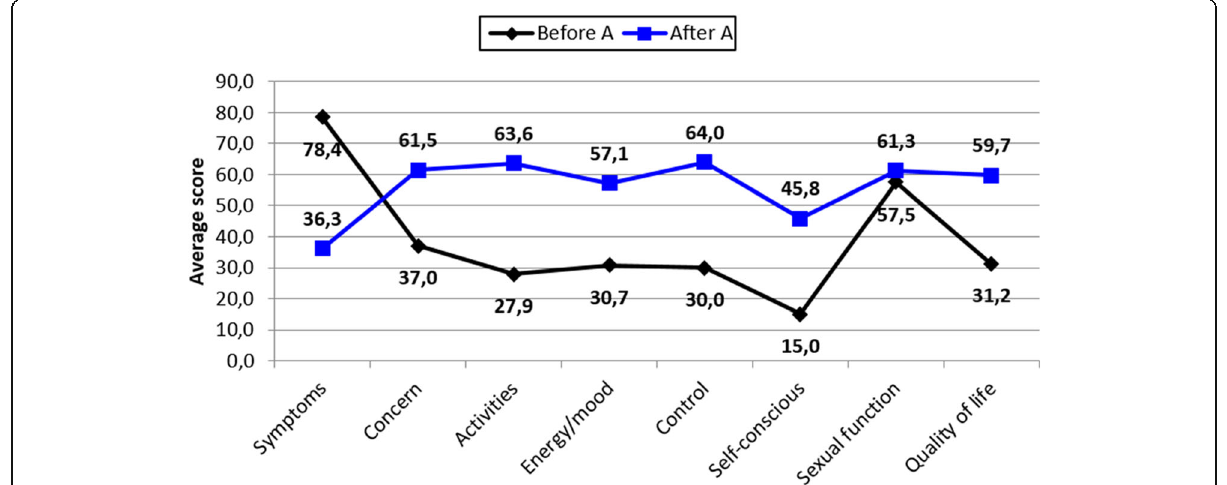
Fig. 3 Average score obtained in the UFS-QOL questionnaire, before and after UFE, in group